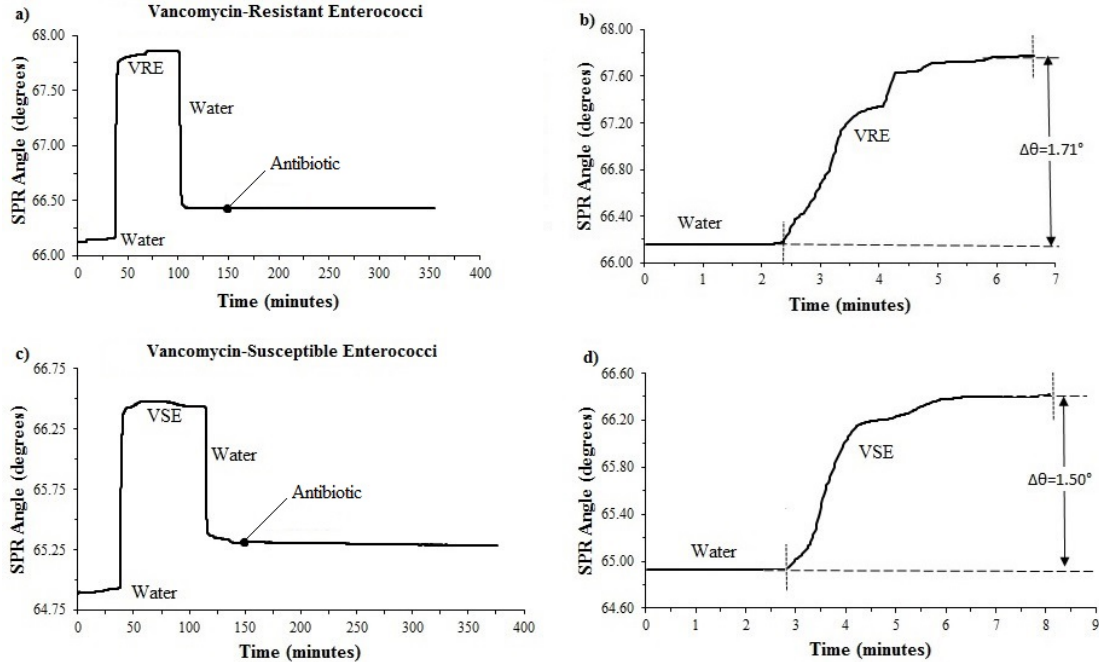
Figure 4. SPR angle shift of vancomycin-resistant (strain VRE 5) and susceptible enterococci (strain VSE 8): ( a ) Kinetic plot of SPR angle shift of vancomycin-resistant enterococci to vancomycin antibiotic for 200 min; ( b ) SPR response of resistant bacterial insertion; ( c ) kinetic plot of SPR angle shift of vancomycin-susceptible enterococci to vancomycin antibiotic for 200 min; ( d ) SPR response of susceptible bacterial insertion.